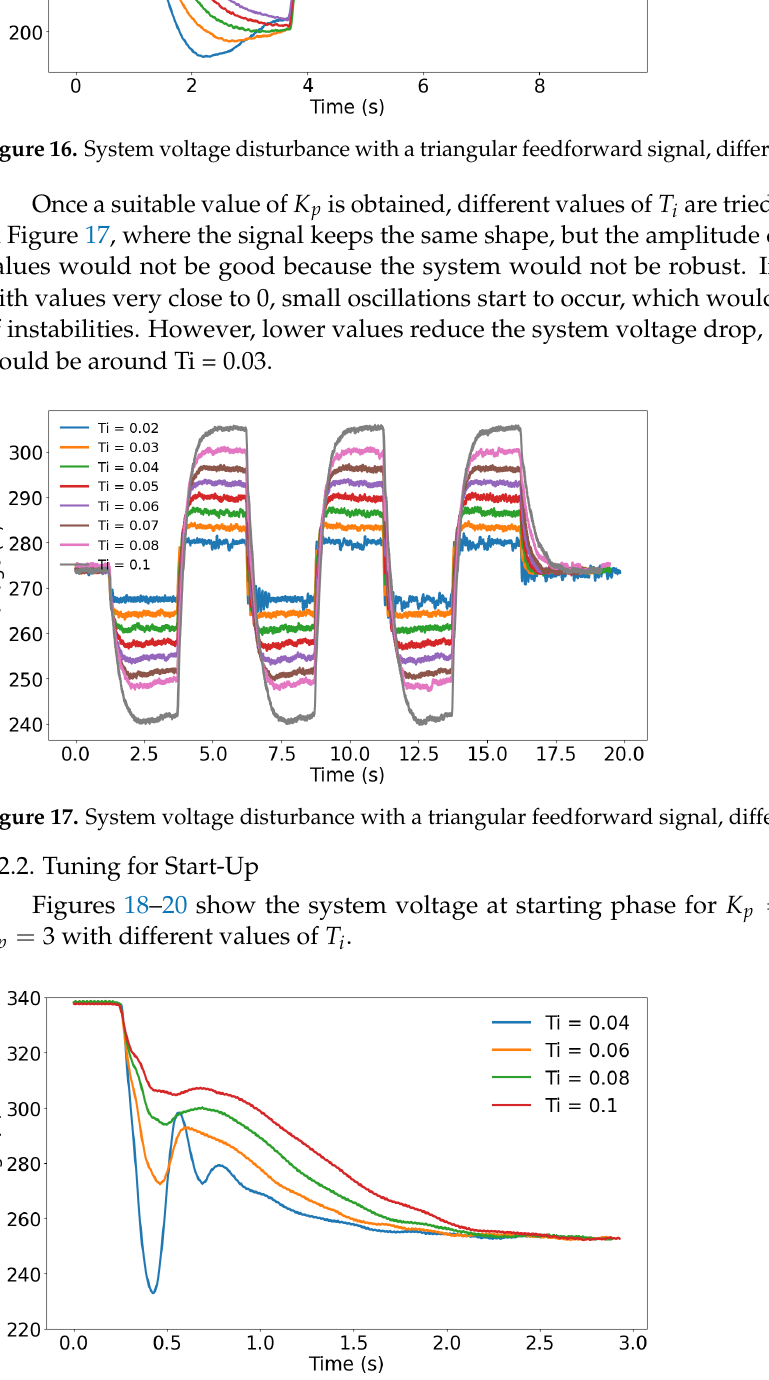
Figure 18. System voltage signal at the starting phase with K p = 1 and different T i